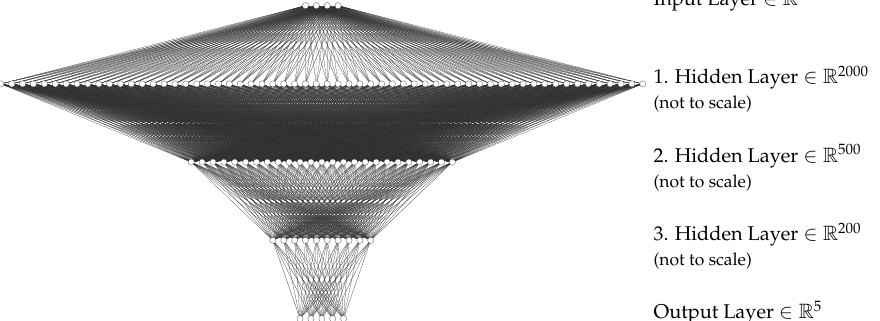
Figure 3. The artificial neural network used within this contribution. The size of the hidden layers is not to